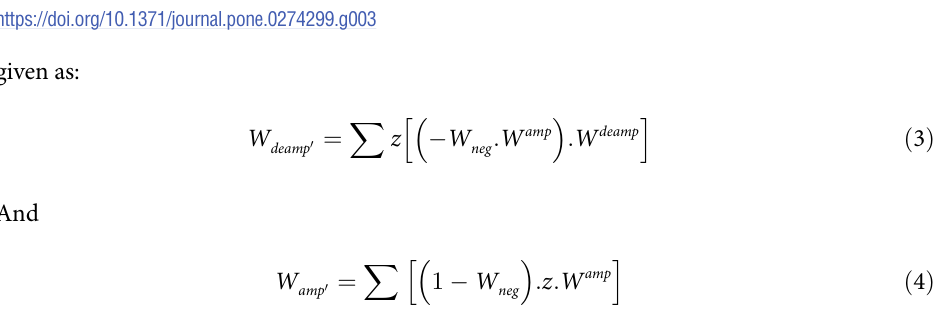
Fig 3. Negator cancellation effect. The diagram shows the net negation effects of words in a sentence.